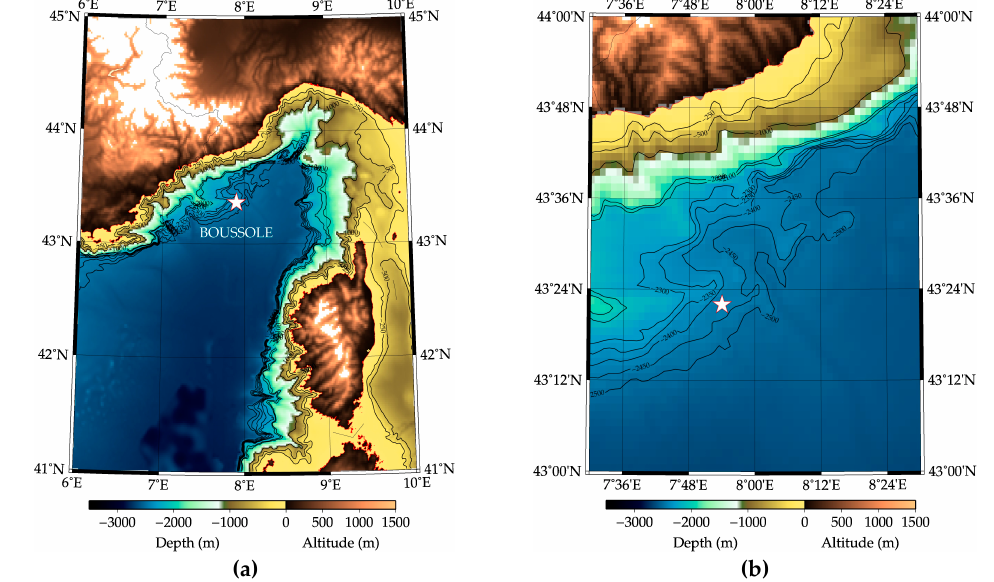
Figure 2. (a) The BOUSSOLE site location in the NW Mediterranean Sea (white star) including bathymetry of the area and (b) zoom on the site itself showing more details of the bathymetry.